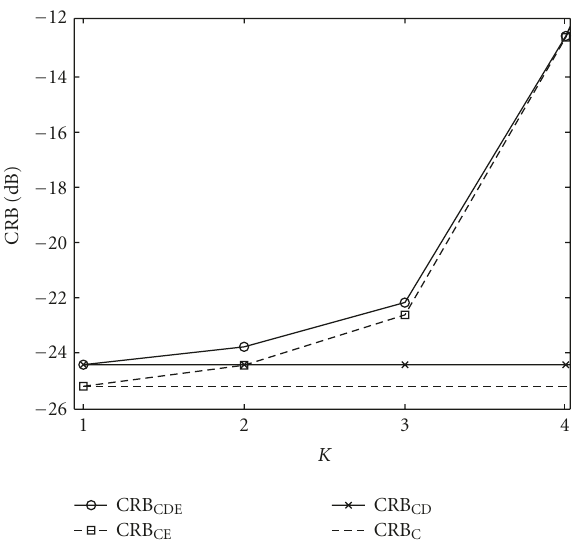
Figure 5: The CRB for the elements of C under di ff erent assump- tions on whether D , E are known or not, and for di ff erent K . SNR is 0dB.